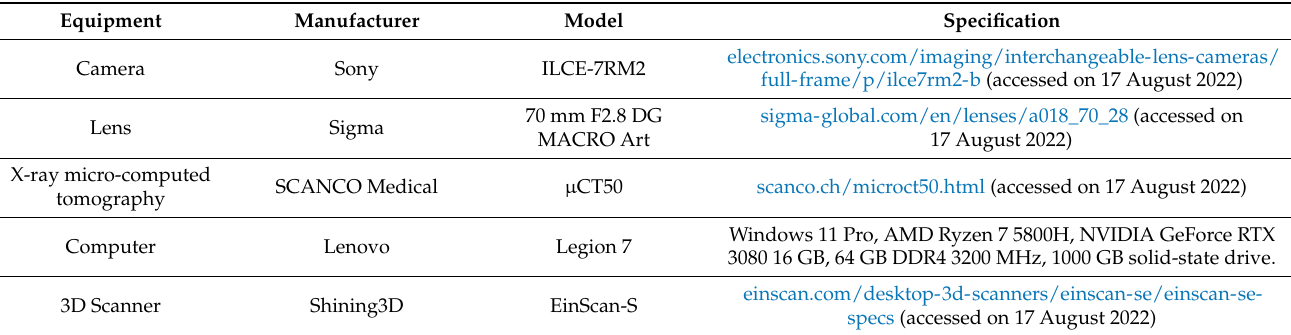
Table 1. The list of used technical equipment.